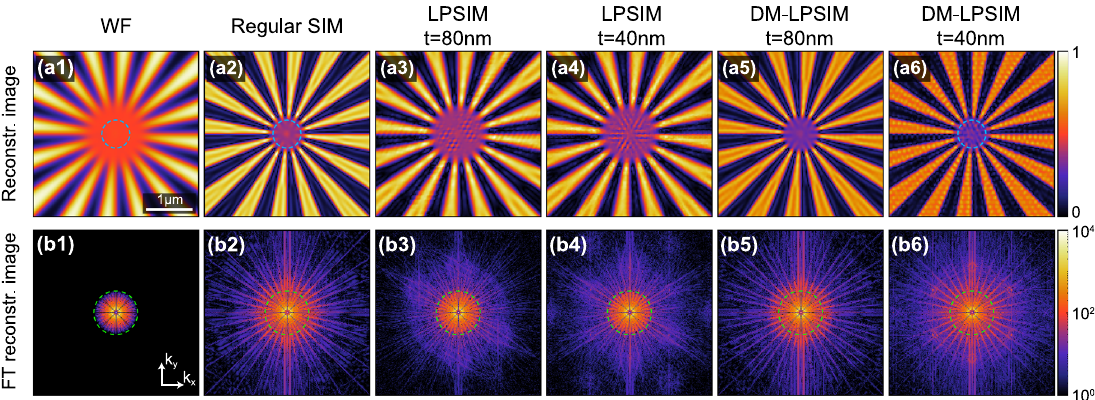
Figure 3: Reconstruction results for simulation configuration A 1 . (a1) WF image at NA = 1.4. (a2 – a6) Reconstructed images using regular structured illumination microscopy (SIM), localized plasmon SIM (LPSIM), and double moiré localized plasmon SIM (DM-LPSIM) illuminations. The LPSIM and DM-LPSIM reconstructions are shown for particle distancesof t =80and40nm,respectively.(b1 – b6)Fouriertransformsof(a1 – a6).Thebluedashedcirclesinpanels(a1),(a2)and(a6)indicate the radius of the cross-cuts shown in Figure 4(c). The green dashed circles in panels (b1 – b6) indicate the cutoff frequency of WF